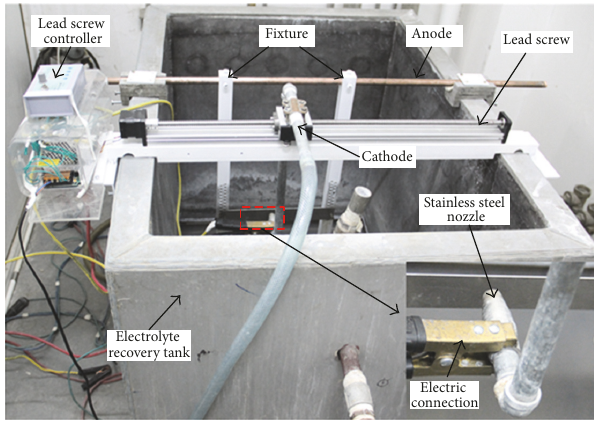
Figure 1: Photograph showing the SMAO set-up used in the